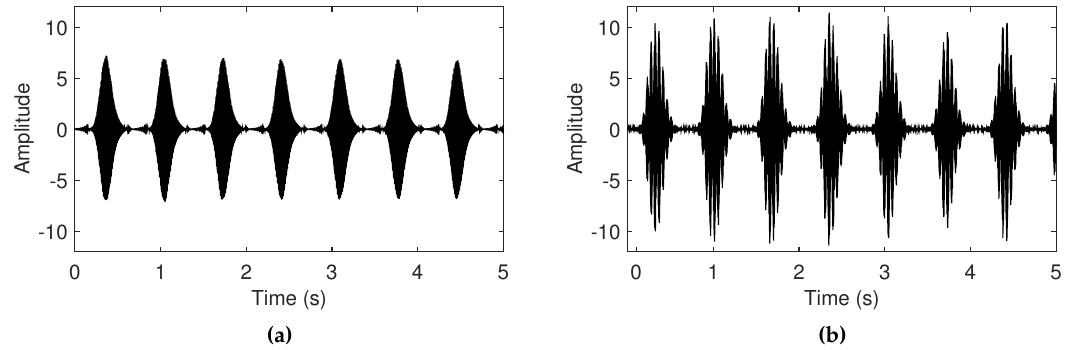
Figure 6. Simulated amplitude control of feedback sounds when the low and high threshold values are ( a ) small (0.3 and 0.6) and ( b ) large (0.5 and 1.0). The length of the delay line is set to 30,000 samples (1.47